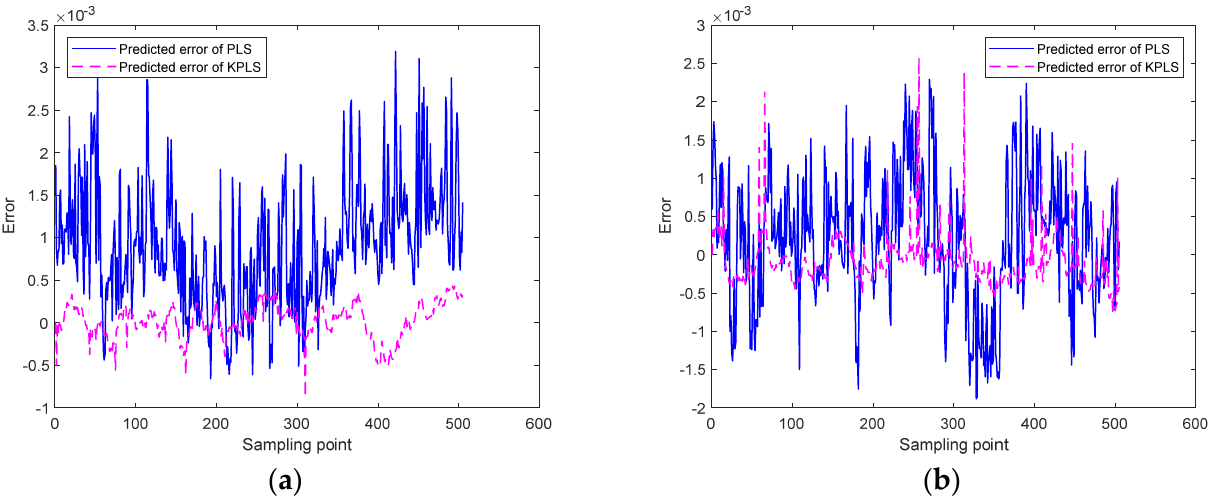
Figure 9. Multimode Mach number prediction errors of the mean-value PLS and mean-value KPLS models. ( a ) Test data 1. ( b ) Test data 2.